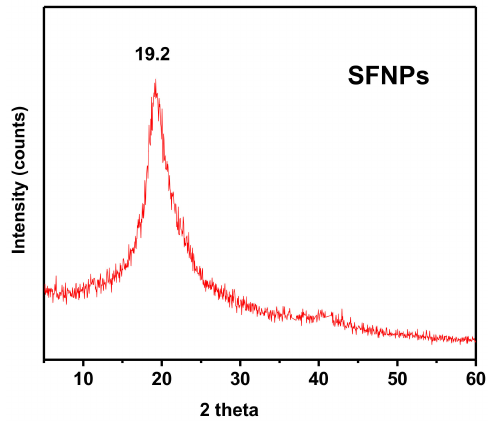
Figure 1. XRD patterns of silk fibroin nanoparticles (SFNPs).